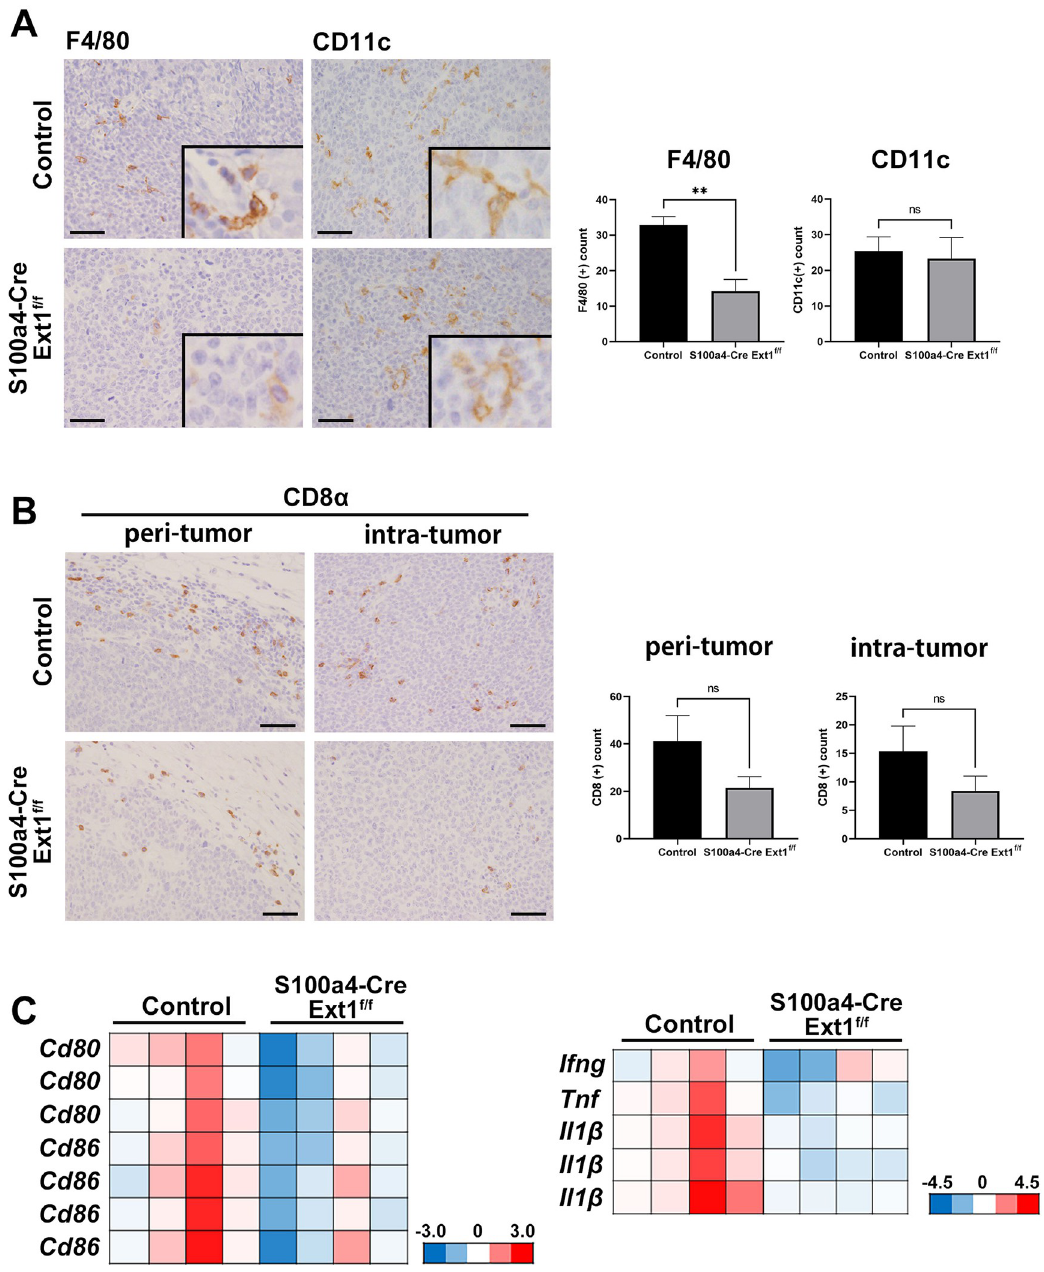
Fig 4. Change of the immune microenvironment in MC38 S.C. tumors of S100a4-Cre; Ext1 f/f mice. (A) Immunohistochemistry for F4/80 and CD11c of MC38 S.C. tumor of S100a4-Cre; Ext1 f/f and control mice (left). The number of F4/80- and CD11c- positive cells in tumors of S100a4-Cre; Ext1 f/f and control mice (right). Data represent mean ± SEM (N = 6 for each cohort, unpaired t-test, � P < 0.05, �� P < 0.01). Scale bar = 50 μ m. (B) Immunohistochemistry of CD8 α in peri- and intra-tumor regions of MC38 S.C. tumors of S100a4-Cre; Ext1 f/f and control mice (left). The number of CD8 α -positive cells in peri-and intra-tumor regions of tumors of S100a4-Cre; Ext1 f/f and control mice (right). Data represent mean ± SEM (N = 6 for each cohort, unpaired t- test). Scale bar = 50 μ m. (C) Microarray analysis of MC38 S.C. tumor of S100a4-Cre; Ext1 f/f and control mice (N = 4 for each cohort). Decreased gene expression is indicated in blue and increased gene expression is indicated in red.